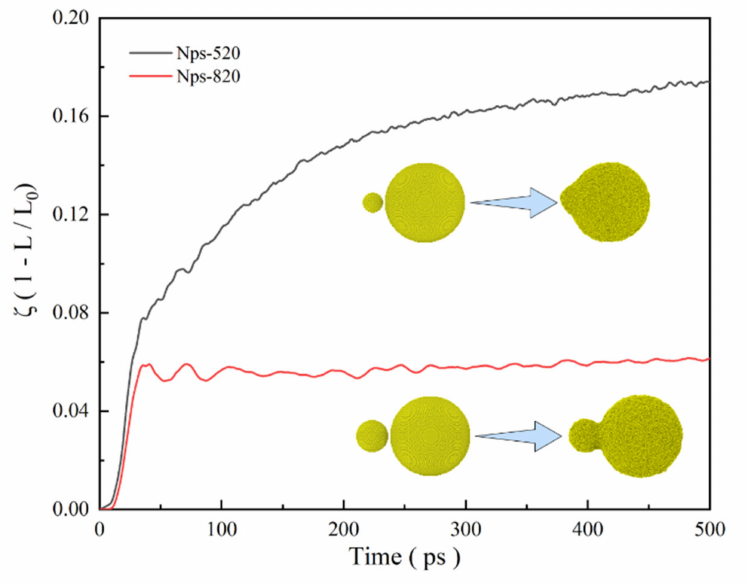
Figure 11. Shrinkage ( ζ ) of two equally sized nanoparticles during the sintering process with a sintering temperature between the